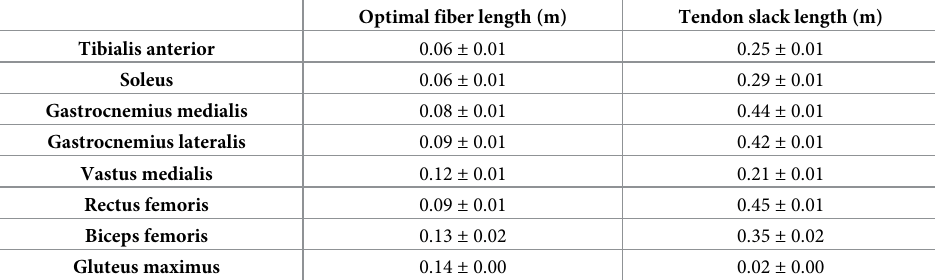
Table 2. Optimized muscle parameters. Optimal fiber lengths and tendon slack lengths that minimize the cost func- tion and were used for calibrating the muscle parameters (mean ± inter-participant